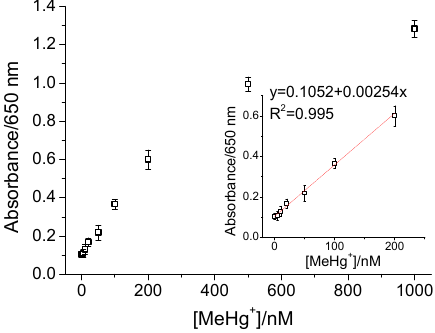
Figure 4. Calibration curve for the detection of CH 3 Hg + . AuNPs, 6.0 × 10 − 10 M; TMB, 1.5 × 10 − 3 M; H 2 O 2 , 1.5 M; Hg 2+ , 4.0 × 10 − 7 M; pH, 4.4; and incubation time, 20 min.